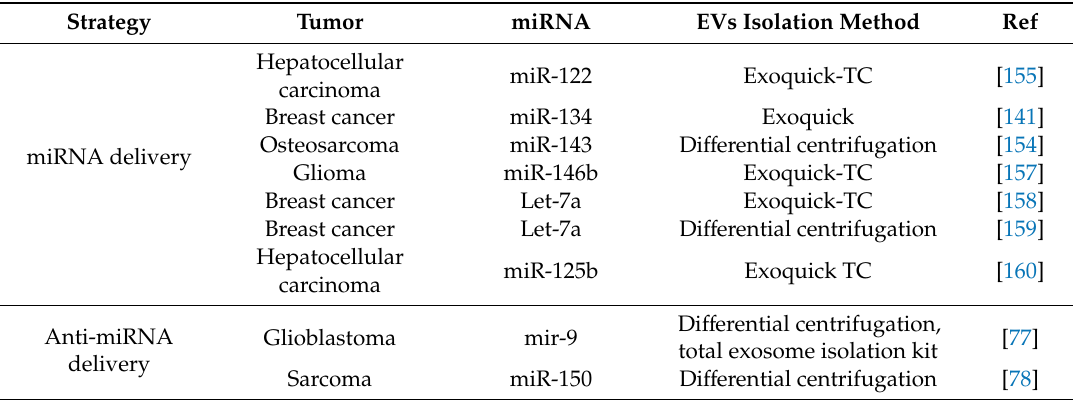
Table 3. EV-mediated miRNA or anti-miRNA delivery in cancer therapy.